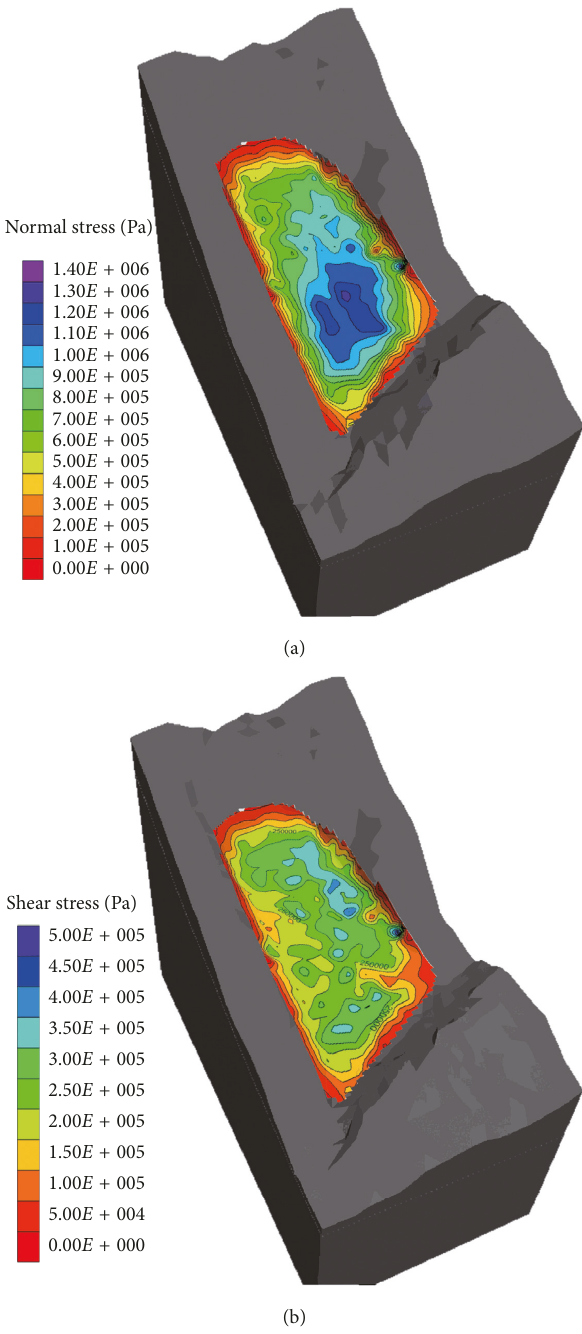
Figure 6: Distribution of normal stress (a) and shear stress (b) at the natural